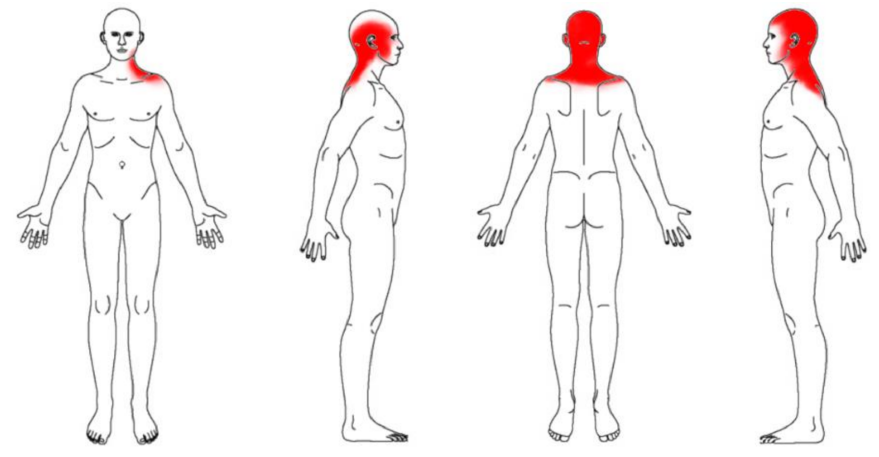
Figure 3. Body Chart used for pain